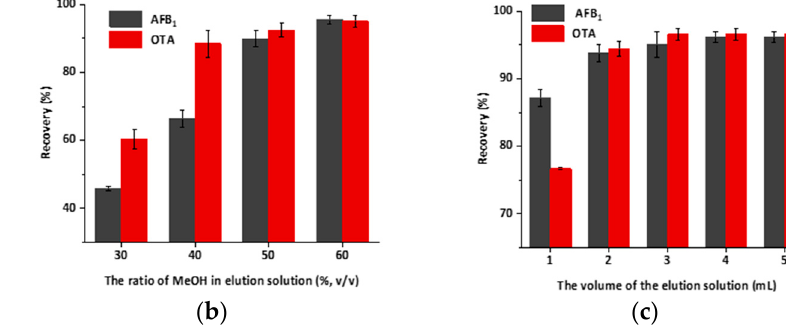
Figure 7. Optimization results of the IAC elution conditions: ( a ) the recovery of AFB 1 and OTA with different kind of elution solution ( n = 3); ( b ) the recovery of AFB 1 and OTA with different ratios of methanol–water as elution solution ( n = 3); ( c ) The recovery of AFB 1 and OTA with different elution volume ( n = 3).